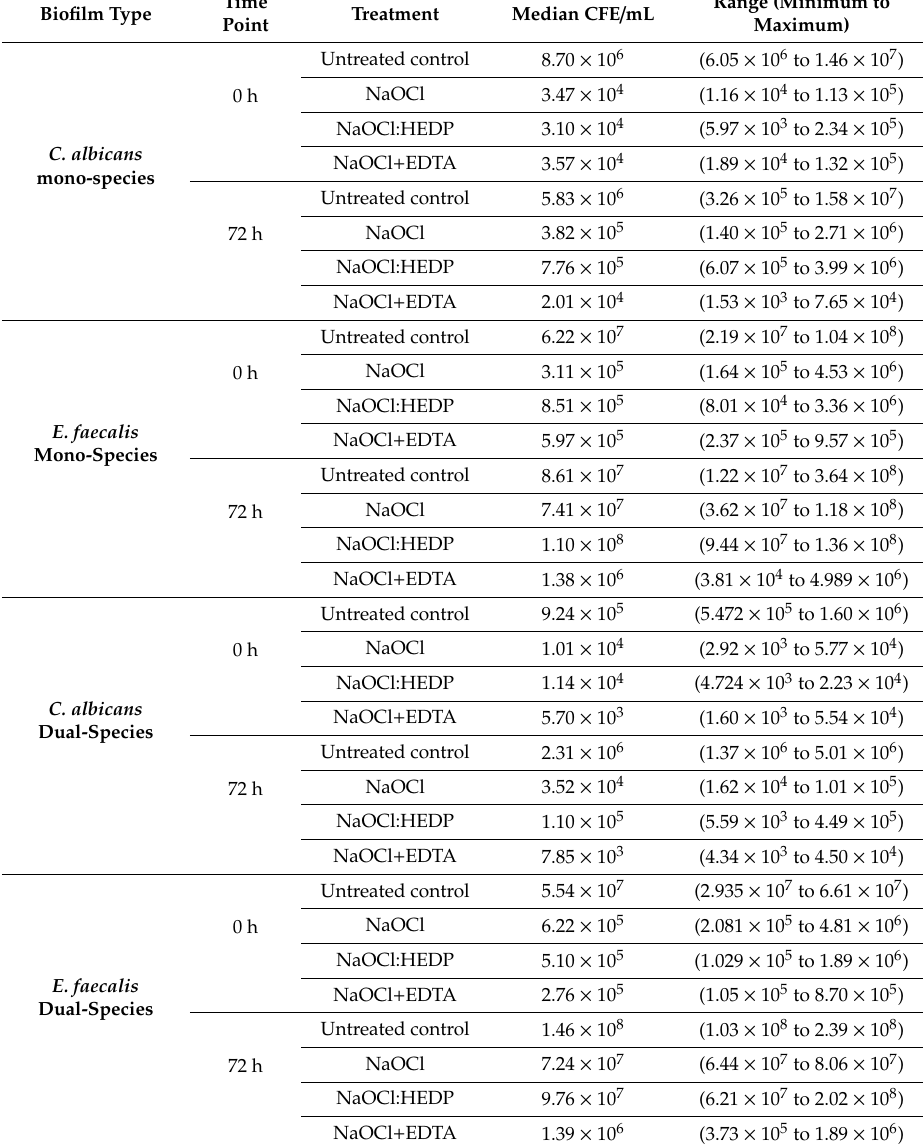
Table 2. The median number and range of CFE / mL for untreated controls, NaOCl, NaOCl:HEDP and NaOCl + EDTA treatment at 0 h and 72